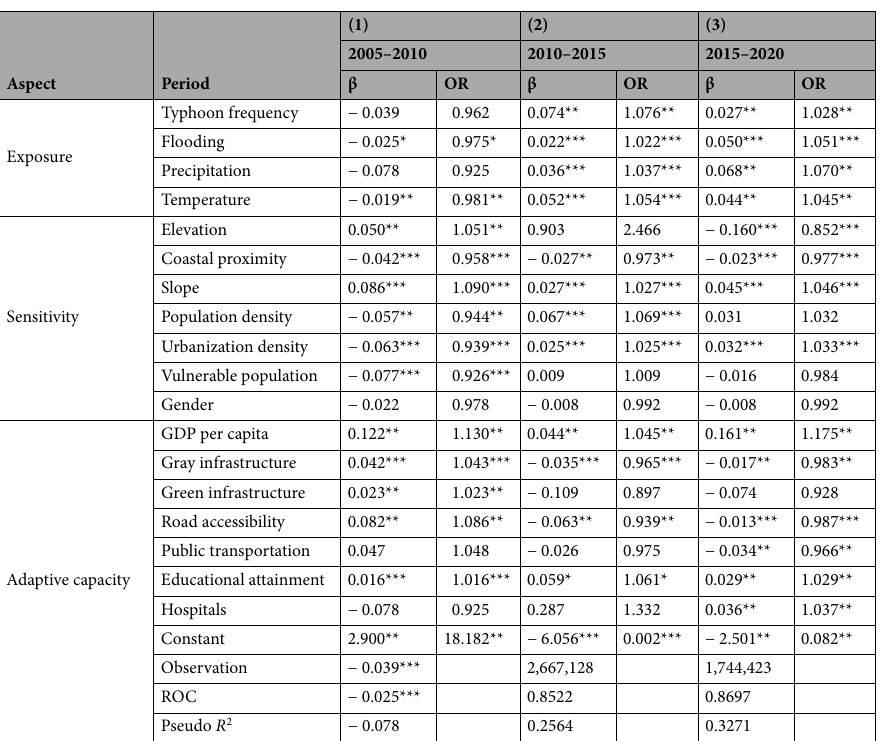
Table 1. Results of logistic regression for all hazards (impact threshold). Dependent variables are change to greenspace (forest, grassland or wetland) from all other land cover types (dummy = 1 if a cell changes to greenspace; 0 otherwise); β = coefficient of independent variables; OR (Odds Ratio) indicates the change in the odds ratio associated with a unit change in the predictor variable; ROC (Relative Operating Curve) is a measure of independent variables’ interpretability on the dependent variable. Standard errors are clustered at the township level; * p < 0.10, ** p < 0.05, *** p <